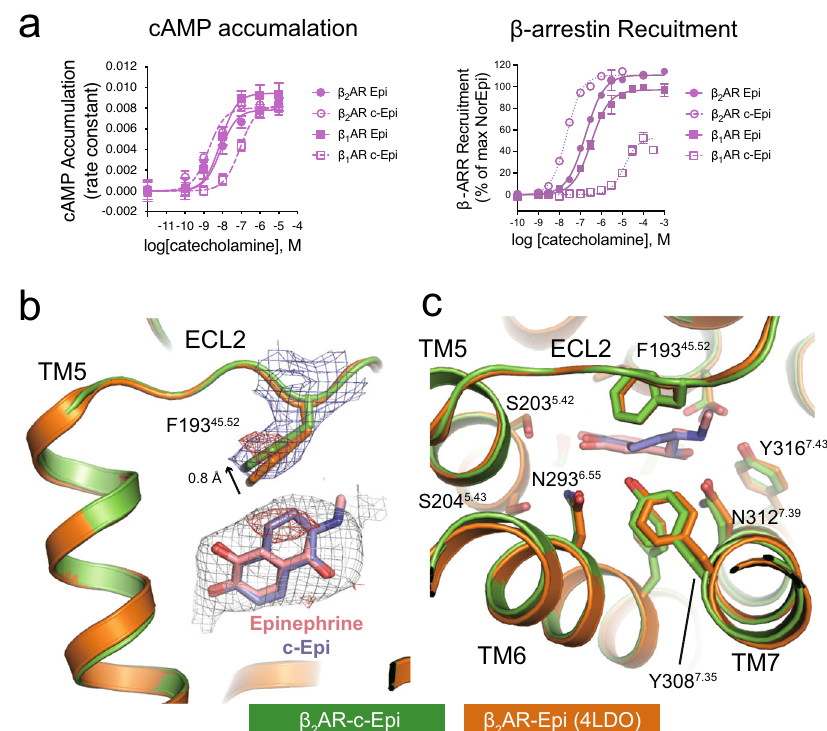
Fig.2|c-Epiisselectivetowardsthe β 2 ARandbindstothesamepositionasEpi does. a c-Epi shows β 2 AR selectivity in both cAMP recruitment and arrestin sig- nalingassays.Dataweregivenasmean±SEMof n =6( β 1 AR forEpi, arrestin), n =15 ( β 1 AR for c-Epi, arrestin), n =17 ( β 2 AR for Epi, arrestin), and n =21 ( β 2 AR for c-Epi, arrestin) independent experiments. Source data are provided asa Source data fi le.